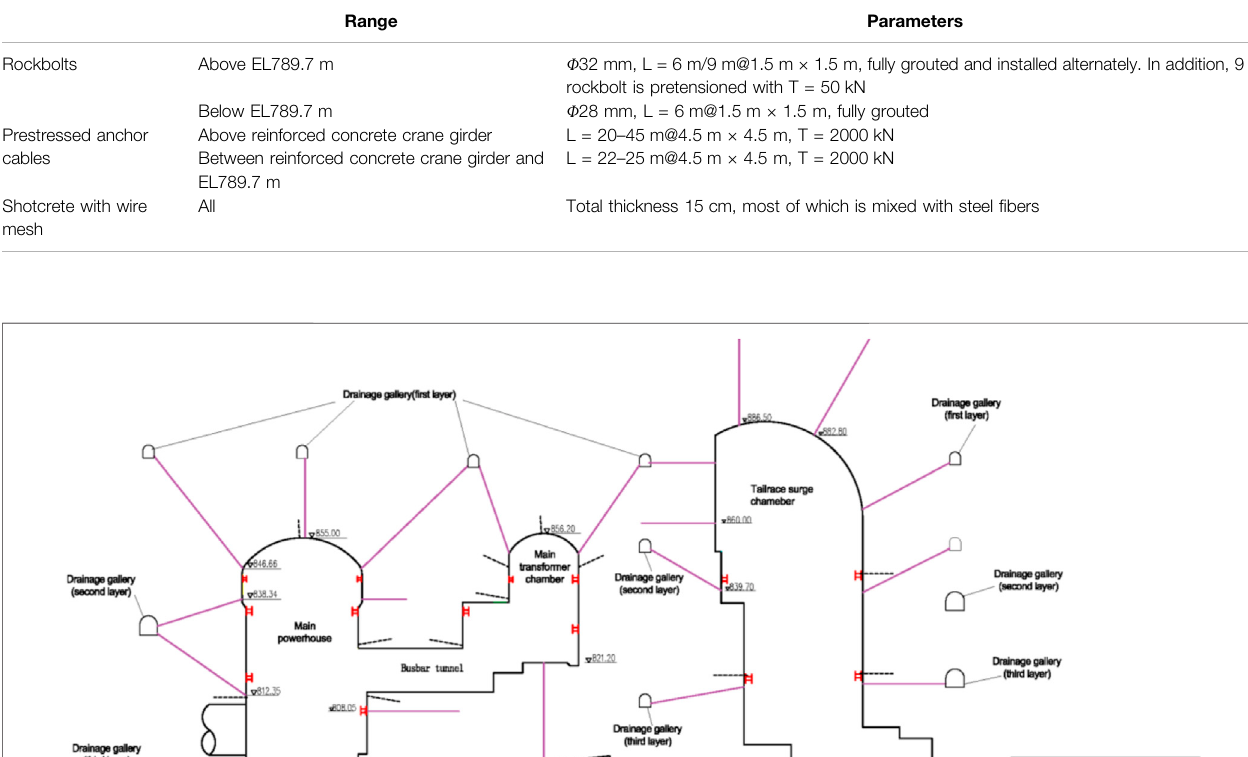
Frontiers in Earth Science |